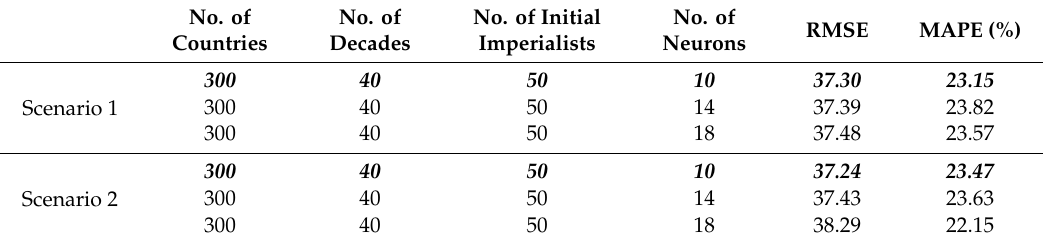
Table 5. MLP-ICA training results (cases).